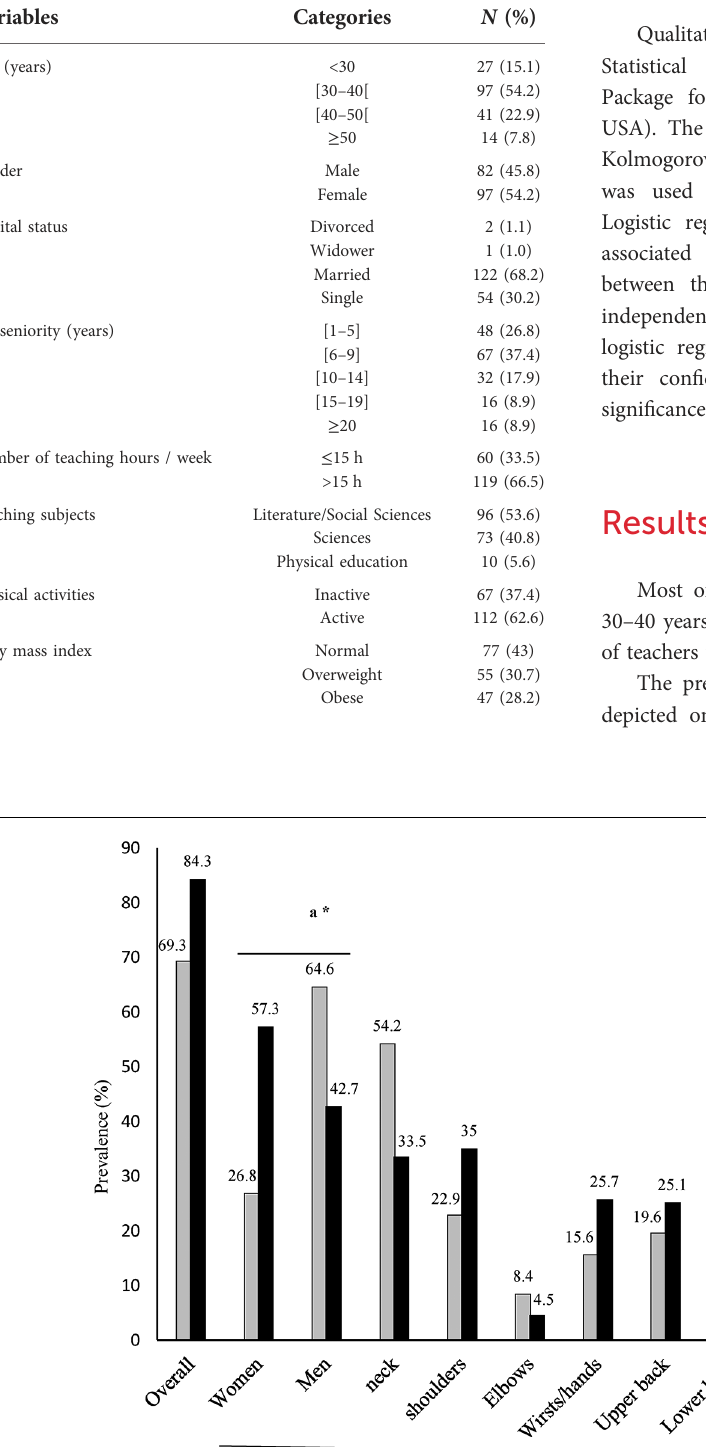
TABLE 1 Socio-demographic and professional characteristics of the participants.